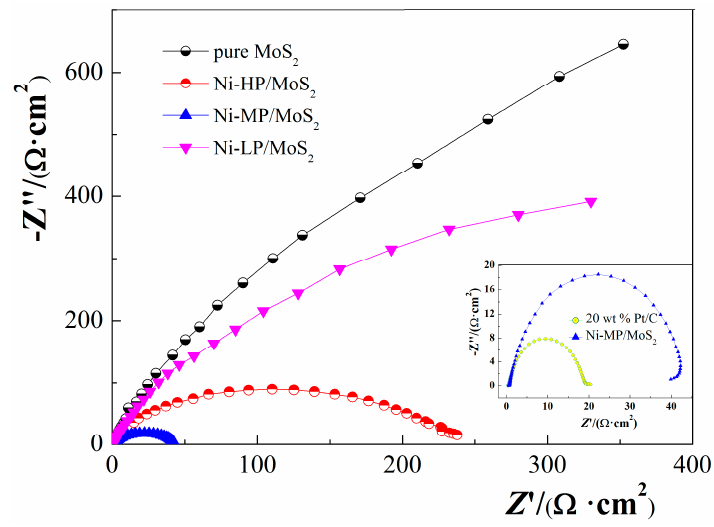
Figure 7. Electrochemical impedance spectroscopy (EIS) curves of the pure MoS 2 , 20 wt % Pt/C, Ni–LP/MoS 2 , Ni–MP/MoS 2 , Ni–HP/MoS 2 . Cathodic overpotential: 0.7 V (vs. RHE), frequency: 100 KHz–10 mHz, amplitude of the sinusoidal signal: 5 mV. Table 2. Parameters of solution resistance ( R s ), charge transfer resistance ( R ct ), double-layer capacitance ( C dl ), the dimensionless CPE exponent m , and exchange current density ( j 0 ) analyzed from the EIS spectra.